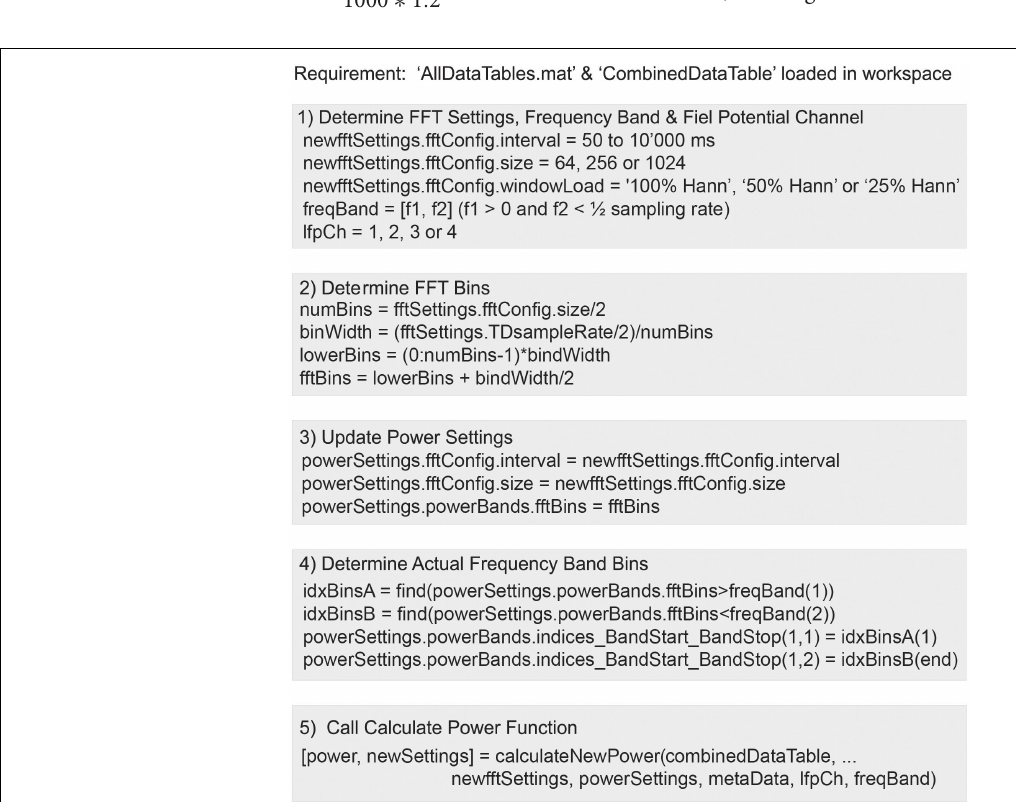
Frontiers in Human Neuroscience |